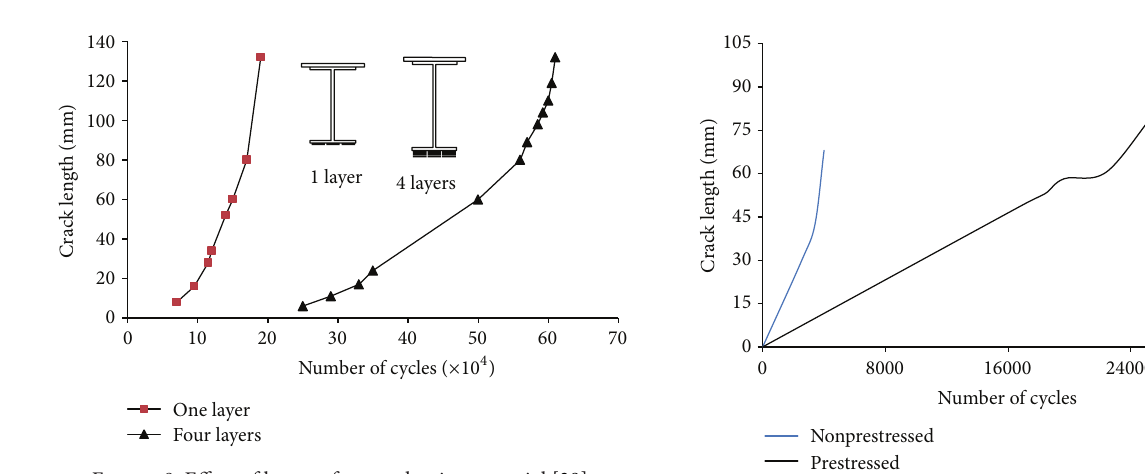
Figure 8: Effect of layers of strengthening material [38].